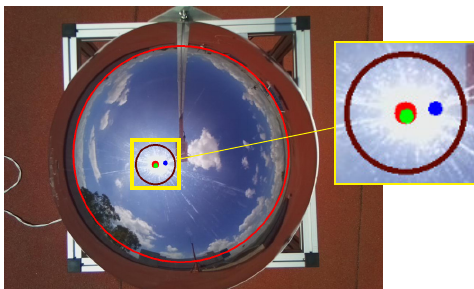
Figure 20. Sun detection (red dot), estimation (blue dot), and tracking (green dot).